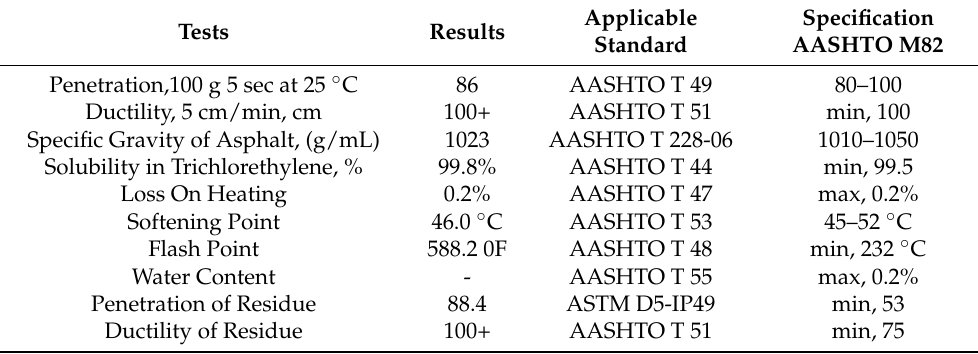
Table 1. Asphalt Cement Quality Test Bitumen